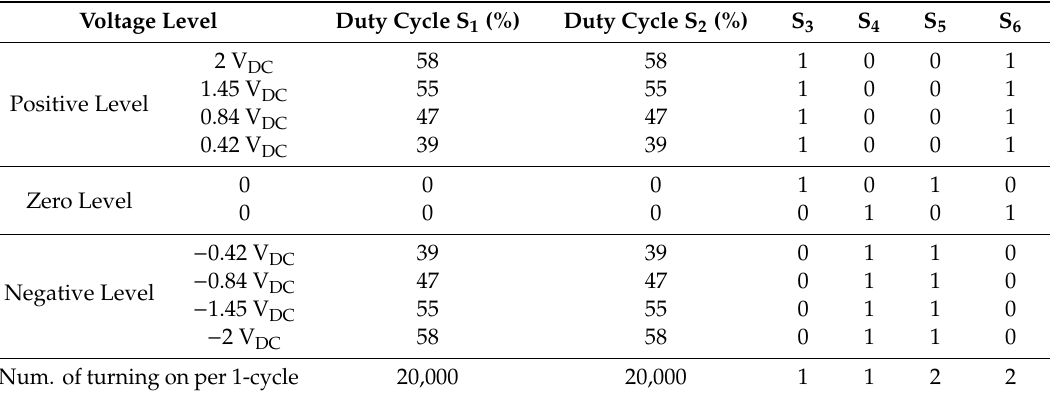
Table 6. Switching table level = 9, gain = 2.